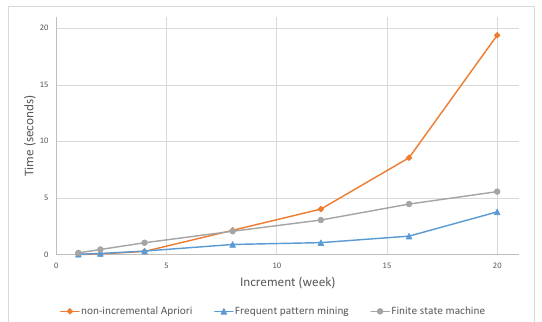
Figure 5: Time required to process a new week of data for both SEM generation methods, compared to a non-incremental method based on original Apri- ori and